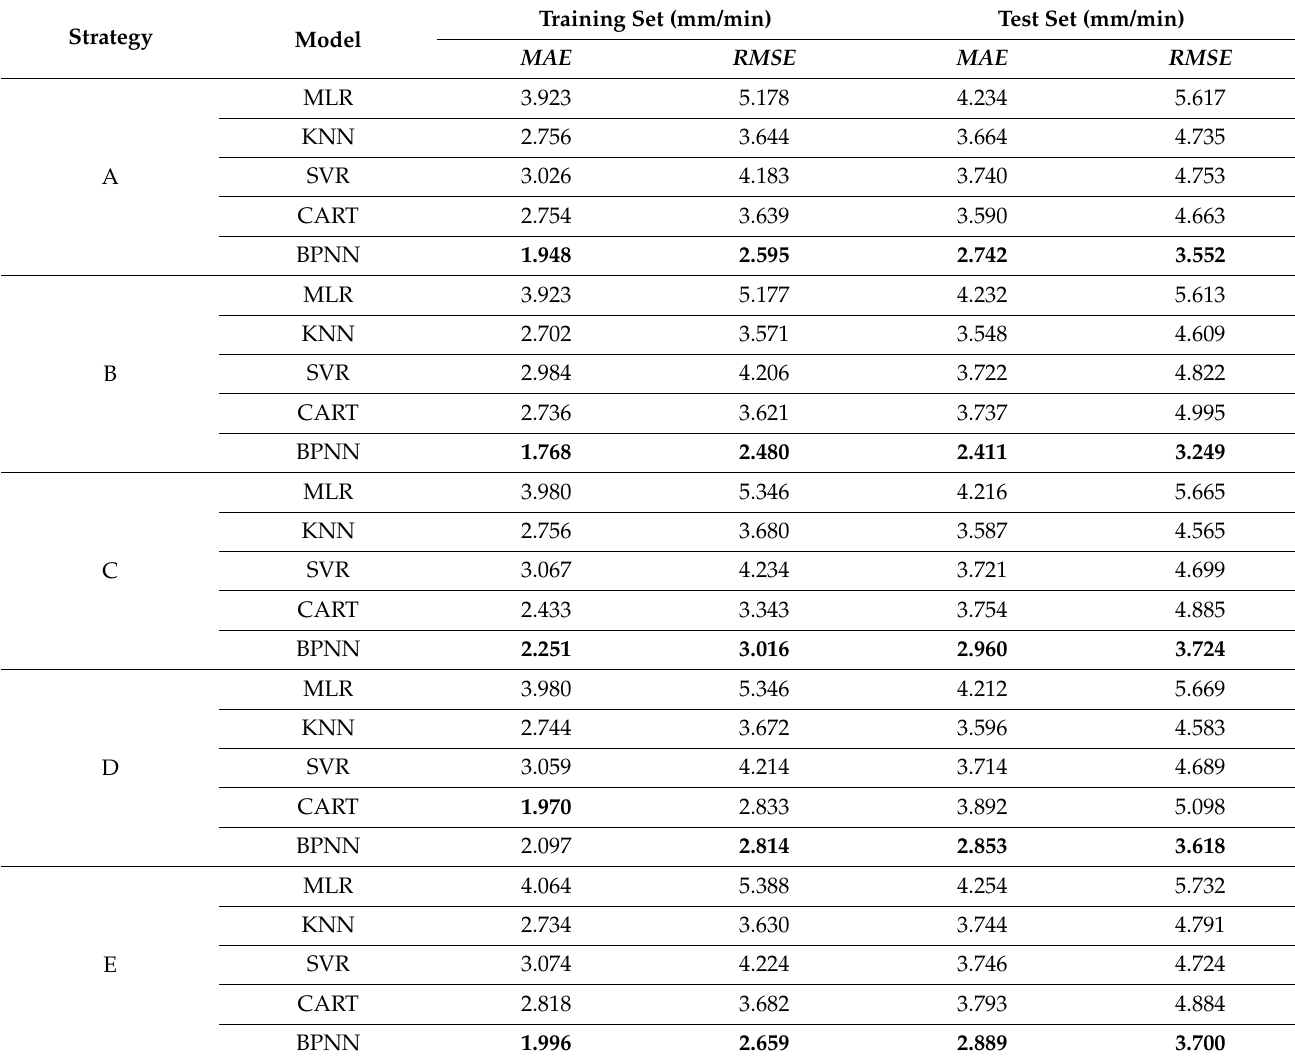
Table 5. MAE and RMSE values of each model in the five